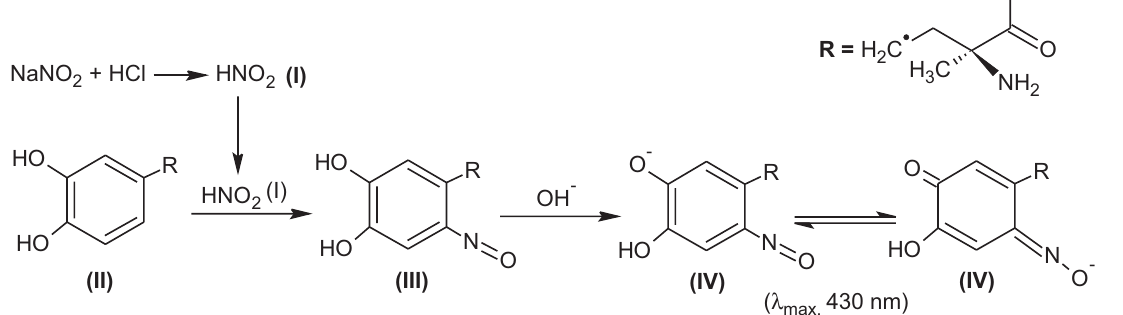
FIGURE 2 - Suggested mechanism of nitration reaction of MTD.